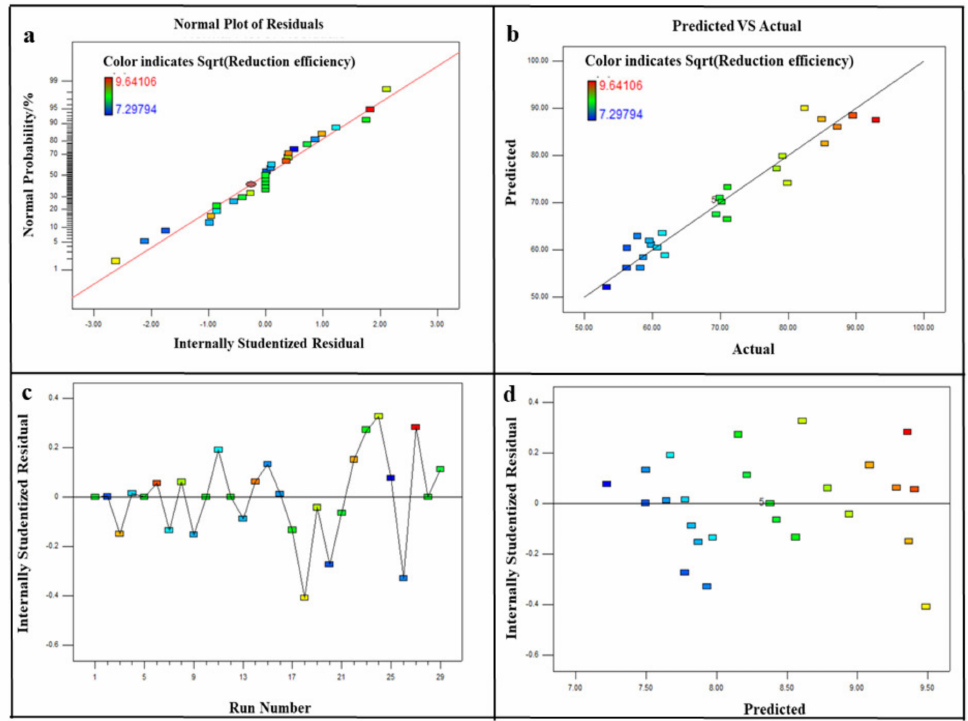
Figure 4. Diagnostic plots of the quadratic model: ( a ) Normal probability against internally studen- tized residuals; ( b ) predicted against actual; ( c ) internally studentized residuals against run number; ( d ) internally studentized residuals against